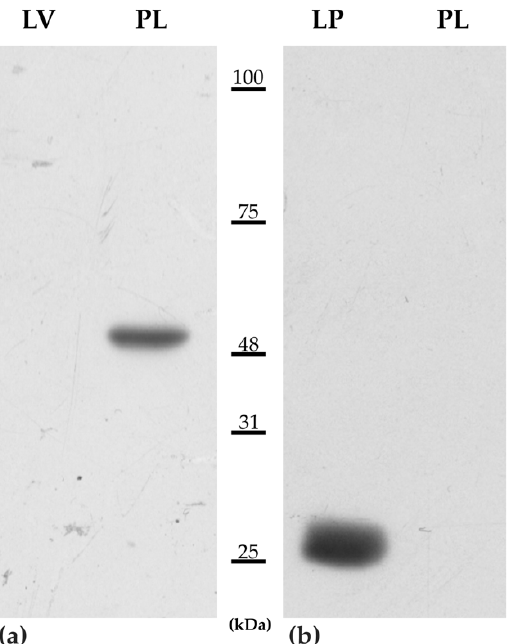
Figure 1. Representative immunoblotting images obtained separating proteins extracted from the equine liver (LV), placenta (PL), and lymph node (LP) on SDS-PAGE 11% T, and detected the immunoreactive bands using the rabbit antibody PD-L1 ( a ) and mouse anti-human CTLA-4 ( b ).